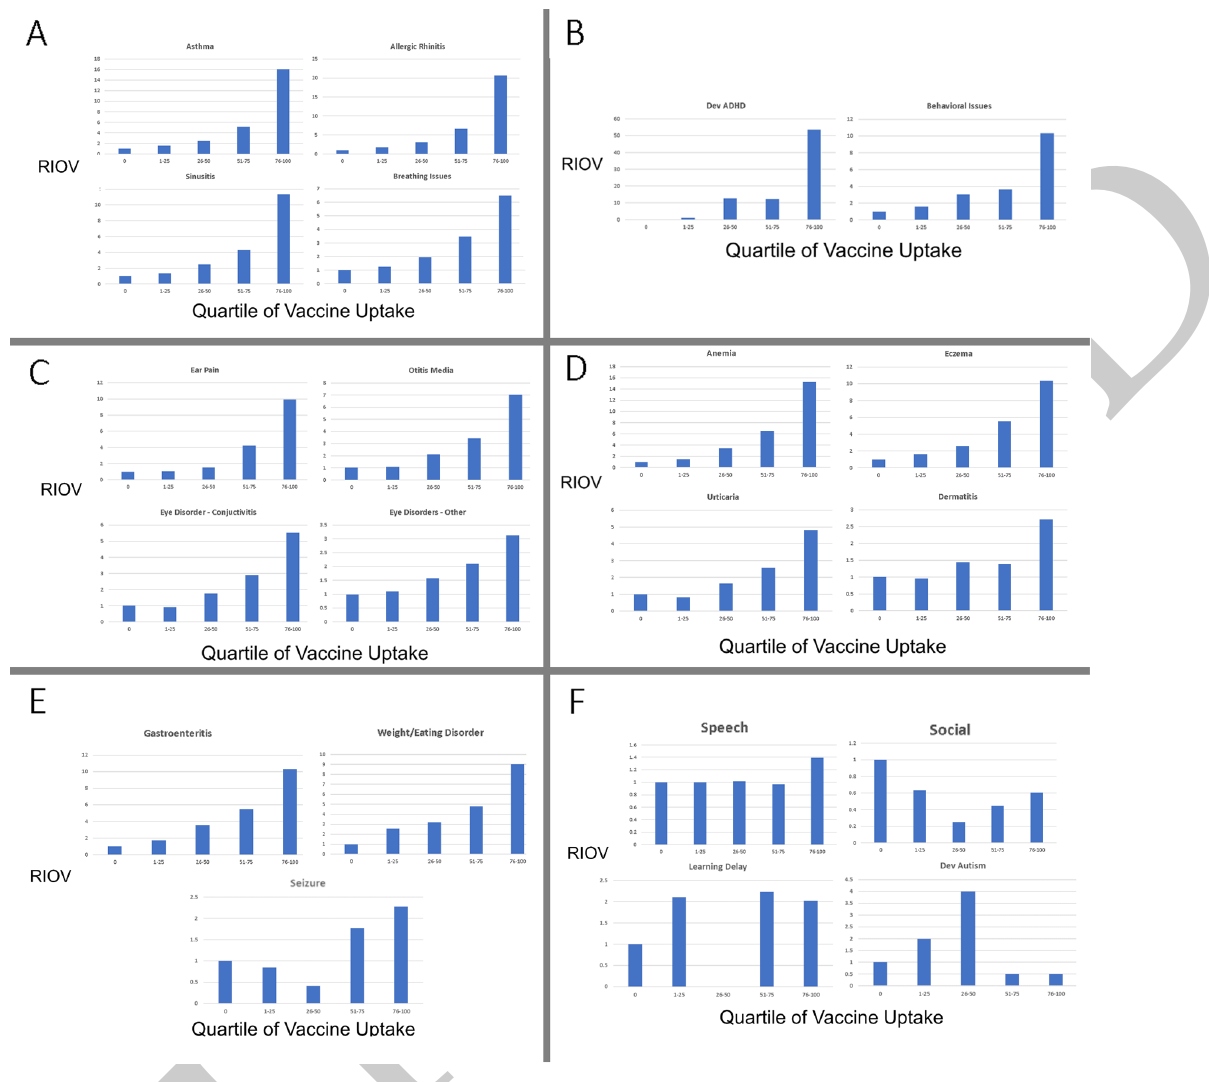
Figure 4. RIOV axis of vaccination percentile vaccine uptake analysis: incidence of study outcome-related o ffi ce visits relative to that found in the 2763 variably vaccinated compared to the 561 unvaccinated groups for each percentile of vaccine uptake on the x -axis. ( A ) Autoimmune respiratory illnesses; ( B ) attention deficit / hyperactive disorder and behavioral issues; ( C ) ear pain, otitis media, and eye disorders; ( D ) autoimmune conditions of the skin and blood; ( E ) gastroenteritis, weight / eating disorders, and seizure; and ( F ) development delays in speech, learning, and social interactions and autism spectrum